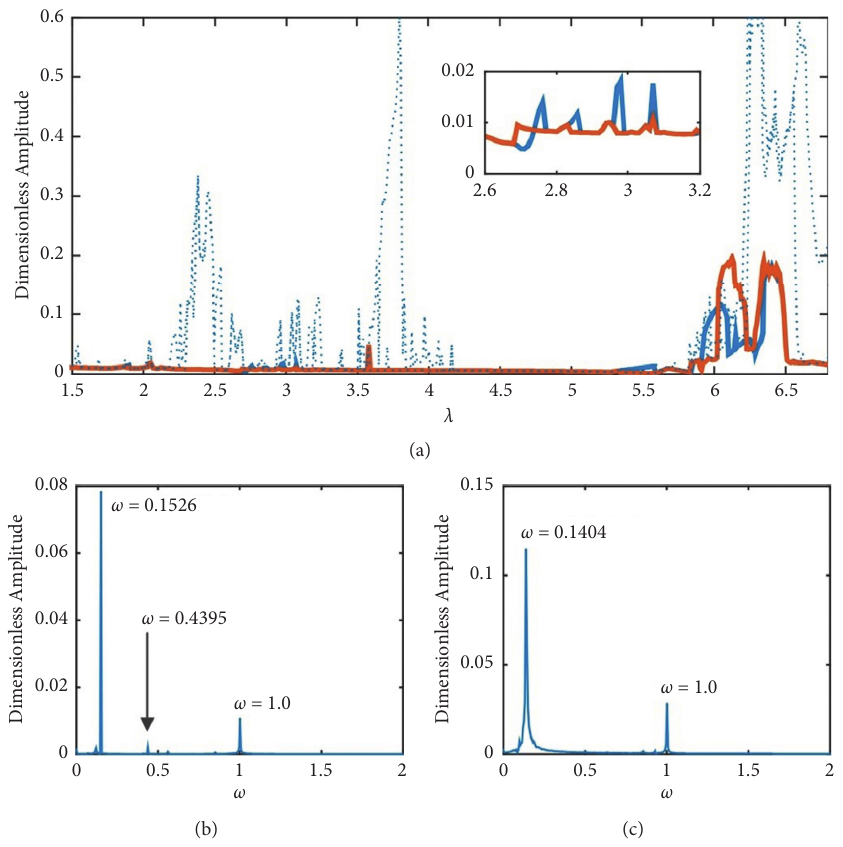
Figure 2: The amplitude-frequency curves in first-order primary resonance region.